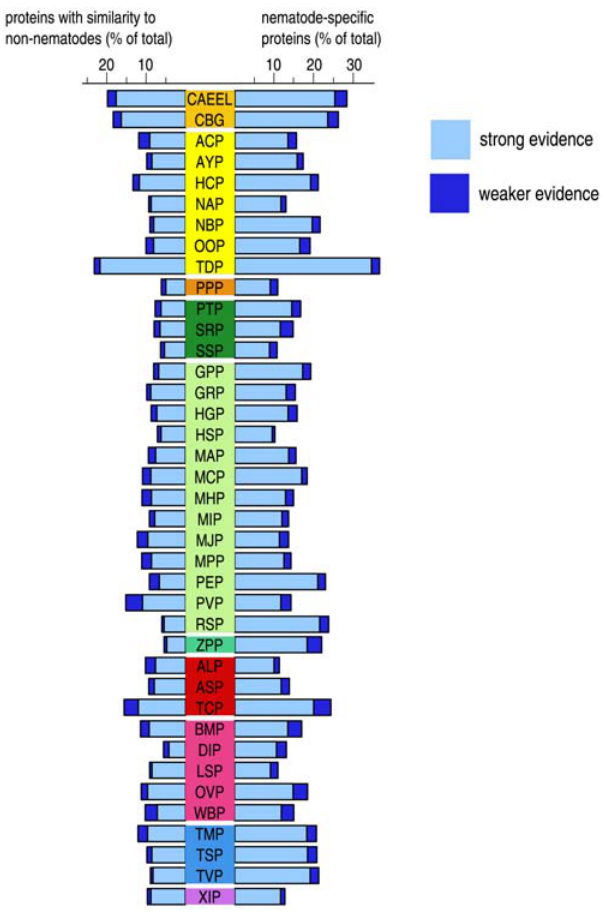
Figure 5. Signal peptides in nematode proteomes in NemPep3. Signal peptides were predicted in NemPep3 using SignalP [53]. For each species the proportion of signal peptide-containing proteins is given. There is a significant increase in the proportion of novel nematode proteins containing signal peptides relative to proteins with homo- logues in other phylum (p , 0.0001; t=10.53230; df=38; paired t-test with data arcsin transformed).